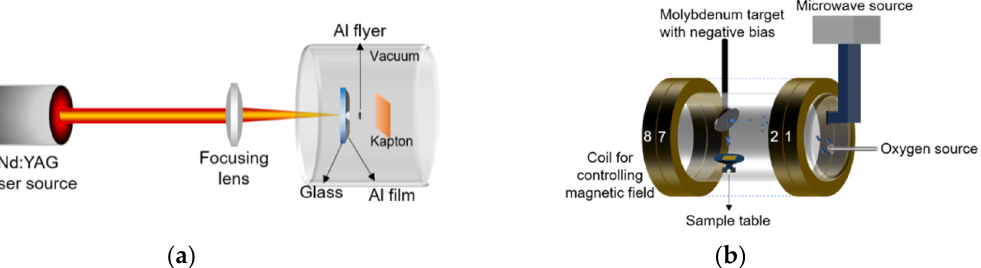
Figure 2. Schematic diagram of ground environment simulation test: ( a ) Laser driven flyer; ( b ) Atomic oxygen erosion.